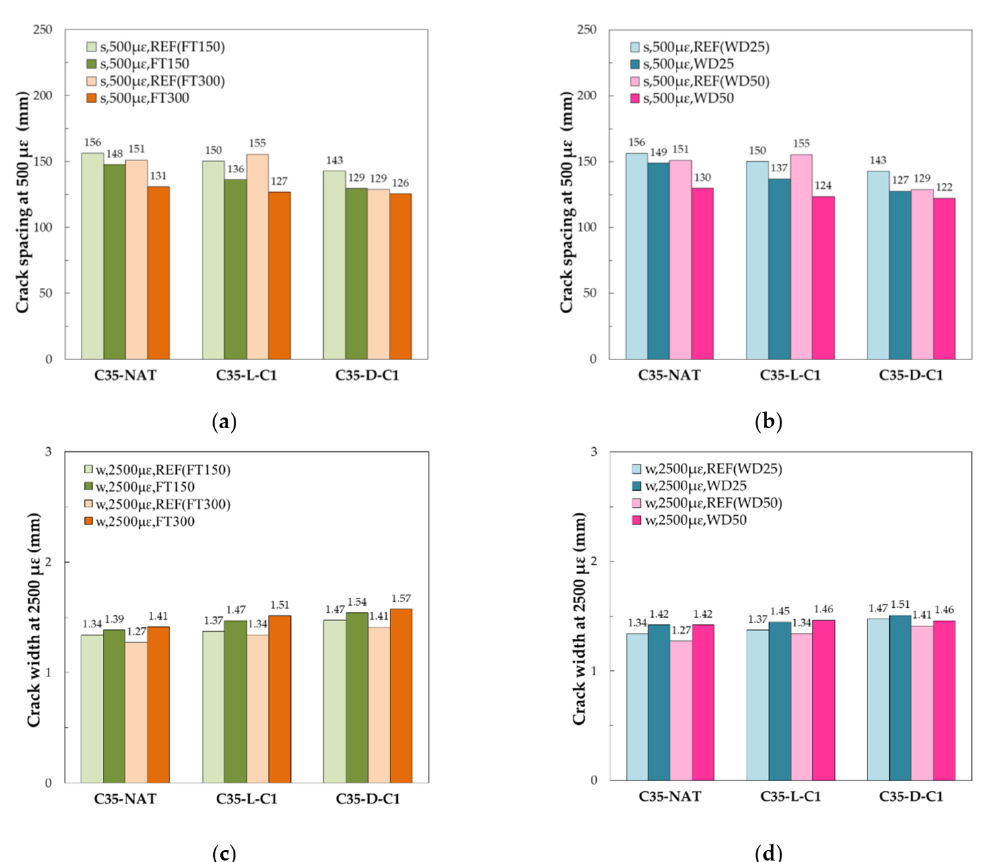
Figure 5. Main properties of crack analysis in the freeze-thaw and wet-dry durability studies: ( a , b ) Initial crack spacing (at 500 µε ); ( c , d ) Final crack width (at 2500 µε ).